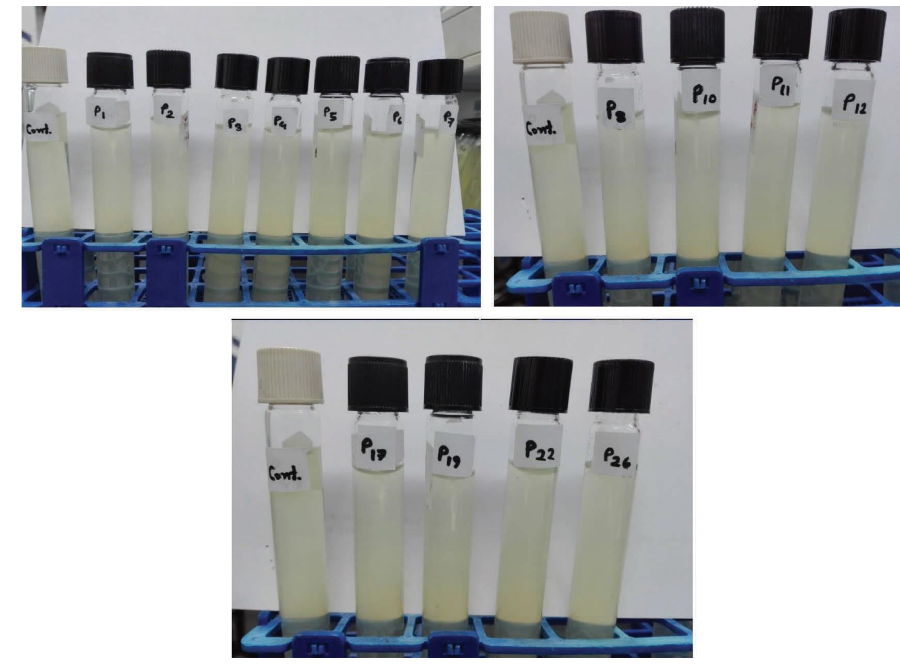
Figure 5: Motility test of diferent isolates. Table 5: Isolate information from the NCBI database.